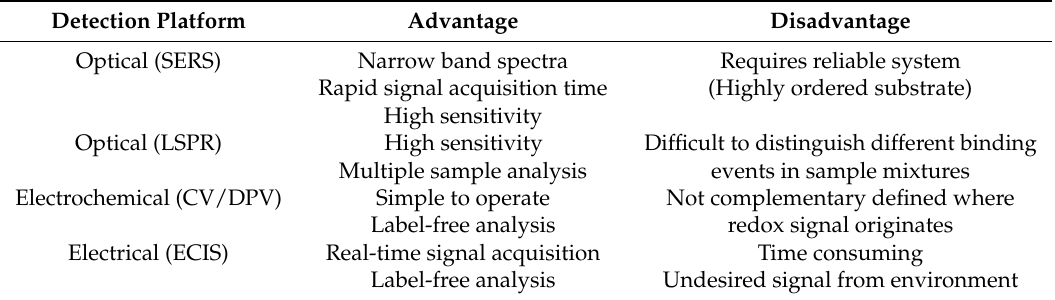
Table 1. Comparison of four techniques based on their advantages and